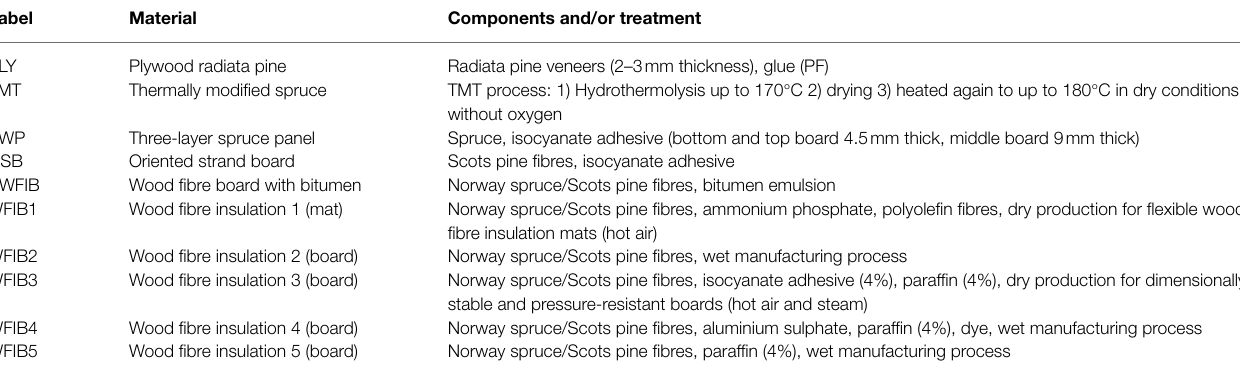
TABLE 1 | Overview of material components and/or treatment. Label Material Components and/or treatment